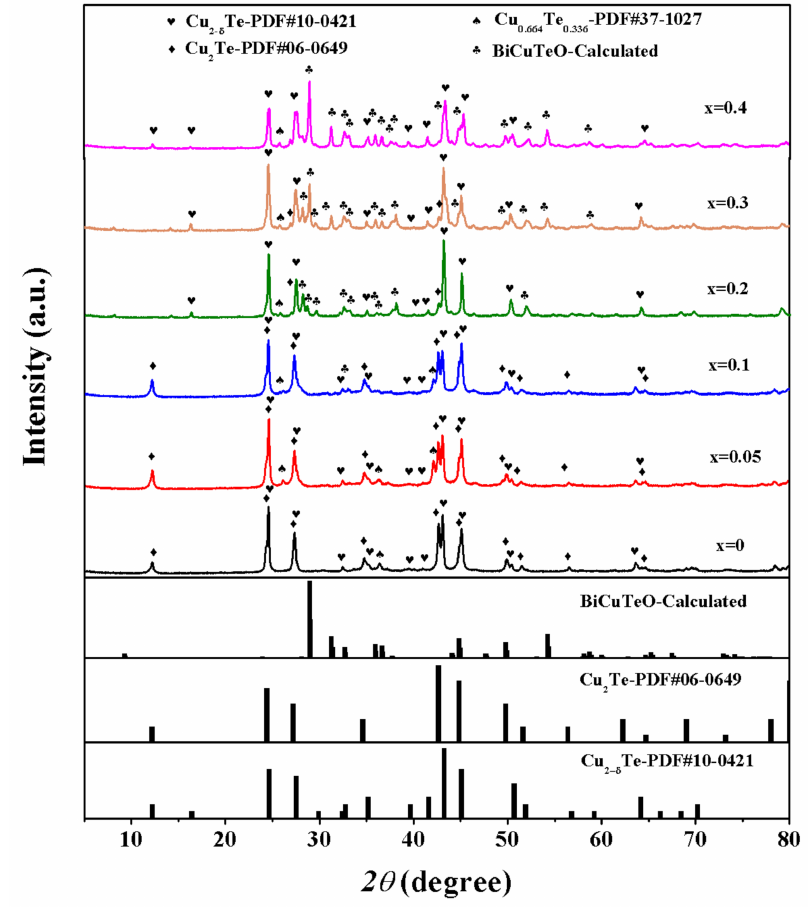
Figure 1. Bulk XRD patterns for (Cu 2 Te) 1 − x -(BiCuTeO) x ( x = 0, 0.05, 0.1, 0.2, 0.3,